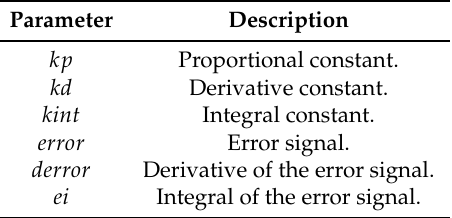
Table A5. Parameters and variables of PID